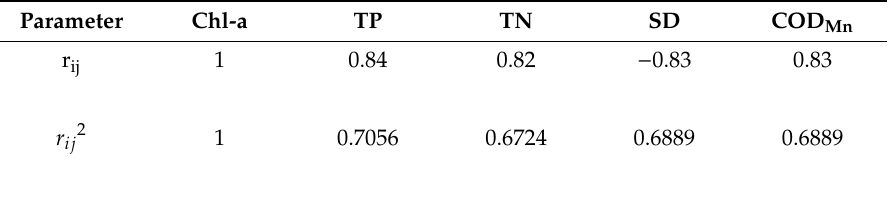
Table 2. Correlation coe ffi cients r ij and r ij 2 between some parameters and Chl-a of lakes (reservoirs) in China.